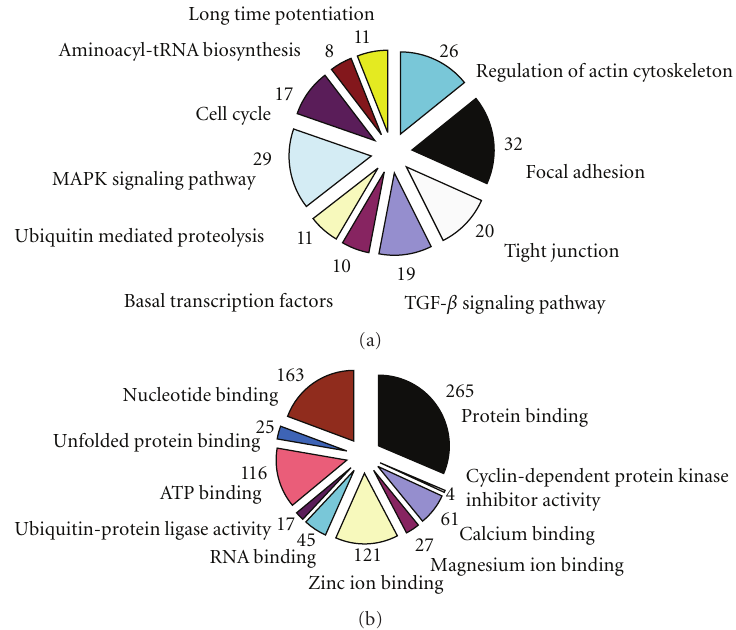
Figure 2: Classification of the di ff erentially expressed genes according to the pathway and GO analysis by MAS software. (a) The top 10 statistically significant ( P < 0 . 001) pathways. (b) The top 10 statistically significant ( P < 0 . 001) molecular functions by GO analysis. The numbers indicated the di ff erentially expressed genes in the specific pathway or